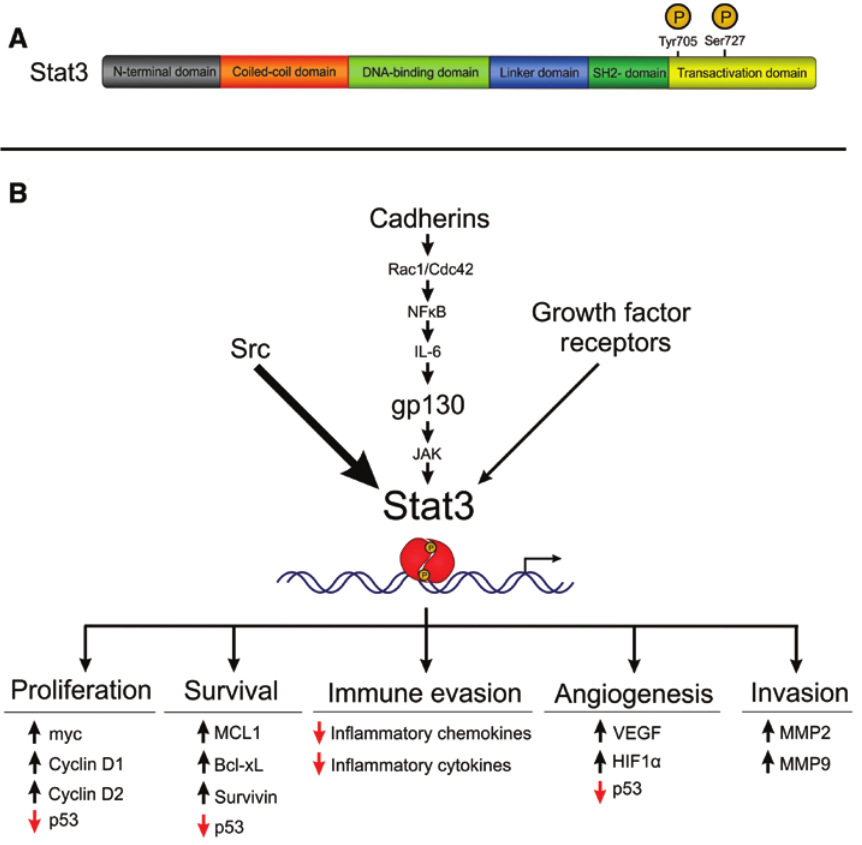
Figure 1: The Stat3 transcription factor. (A) Stat3 functional domains. STAT family proteins (Stat1 to Stat6) differ within the transactivation domain at their C-terminus, but are other- wise similar in structure. The transactivation domain contains two phosphorylation sites, Ser-727 and Tyr-705 in Stat3. Following activation, tyrosine kinases, cytokine receptors or the associated Jak or Src family kinases (3, 21) mediate Stat3-ptyr705 phosphorylation. This permits dimerization through a reciprocal interaction between the phosphorylated residue and Stat3’s SH2 domain, and the complex is then tar- geted to the nucleus. The Stat3, DNA binding domain, which recognizes a 9-bp consensus sequence (TTCNNNGAA), controls transcription by binding DNA in the promoter region of target genes. Ser727 phosphorylation is mediated by the Ras/Erk pathway and Stat3-pser727 is targeted to the mitochondria (160). At the same time, the coiled-coil domain contains a number of sites that facilitate protein-protein inter-